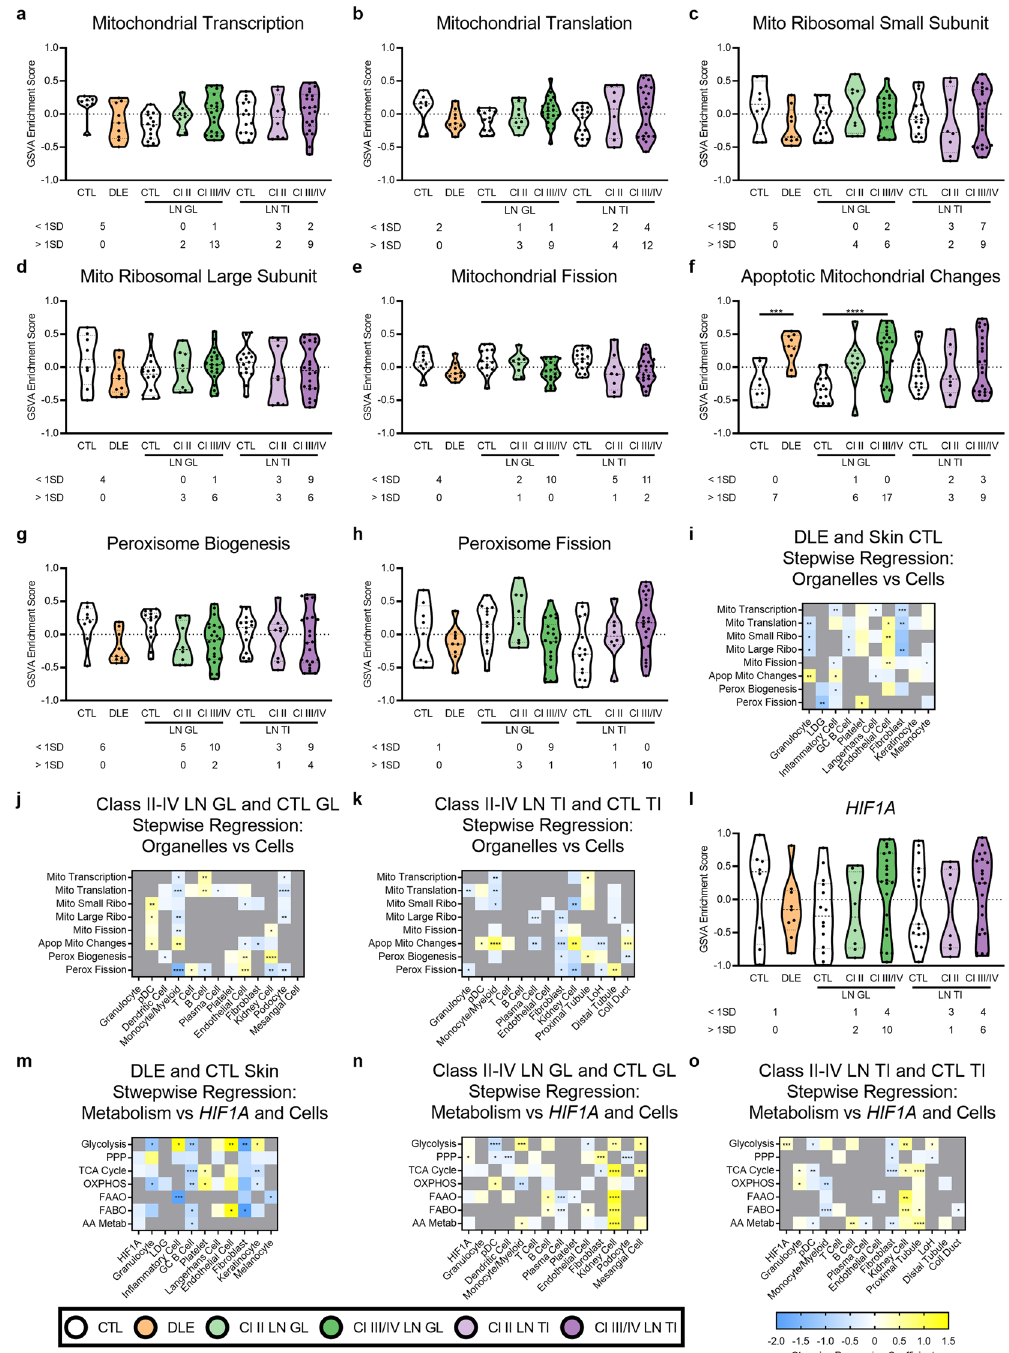
Figure 5. Mitochondrial and peroxisomal signature changes and local hypoxia contribute to changes in metabolic gene expression in specific cells. GSVA of signatures for ( a – f ) mitochondria- or ( g – h ) peroxisome- related gene signatures in lupus tissues and CTLs. Each point represents an individual sample. ( i – k ) Stepwise regression coefficients for mitochondrial and peroxisomal signatures in all tissues and CTLs. ( l ) GSVA of HIF1A in lupus tissues and CTLs. Each point represents an individual sample. ( m – o ) Stepwise regression coefficients for metabolic pathway signatures with the addition of HIF1A in all tissues and CTLsSignificant differences in enrichment of the mitochondrial/peroxisomal signatures or HIF1A in DLE and CTL, Cl II LN GL and CTL, Cl III/IV LN GL and CTL, Cl II LN TI and CTL, and Cl III/IV LN TI and CTL was determined by Welch’s t-test with Bonferroni correction. Numbers below each tissue indicate the number of lupus patients with enrichment scores 1 SD less than (< 1SD) or greater than (> 1SD) the CTL mean. For all calculations, the following sample numbers were used: DLE [CTL (n = 8), DLE (n = 9)], LN GL [CTL (n = 14), Cl 2 (n = 8), Cl III/IV (n = 22)], and LN TI [CTL (n = 15), Cl II (n = 8), Cl III/IV (n = 22)]. Significant p-values in ( i – k , m – o ) reflect significant coefficients in the stepwise regression model. *, p < 0.05; **, p < 0.01; ***, p < 0.001; ****, p <